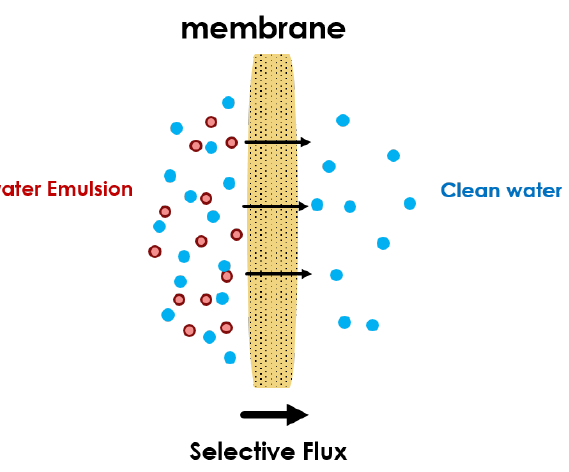
Figure 9. Membrane technology for oil–water separation. The blue circles stand for water droplets and the red circles stand for oil